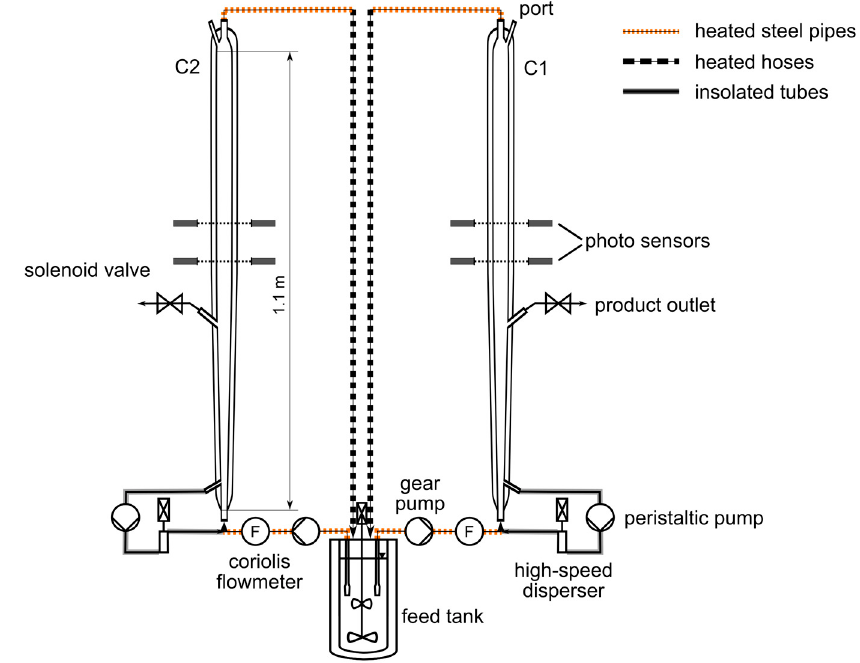
Figure 3. Process scheme with the main components of the utilized continuous fluidized bed plant.